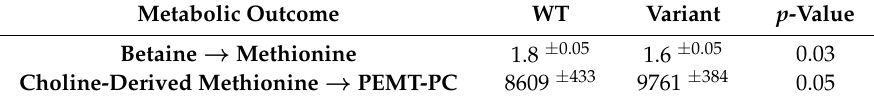
Main effect; p = 0.03